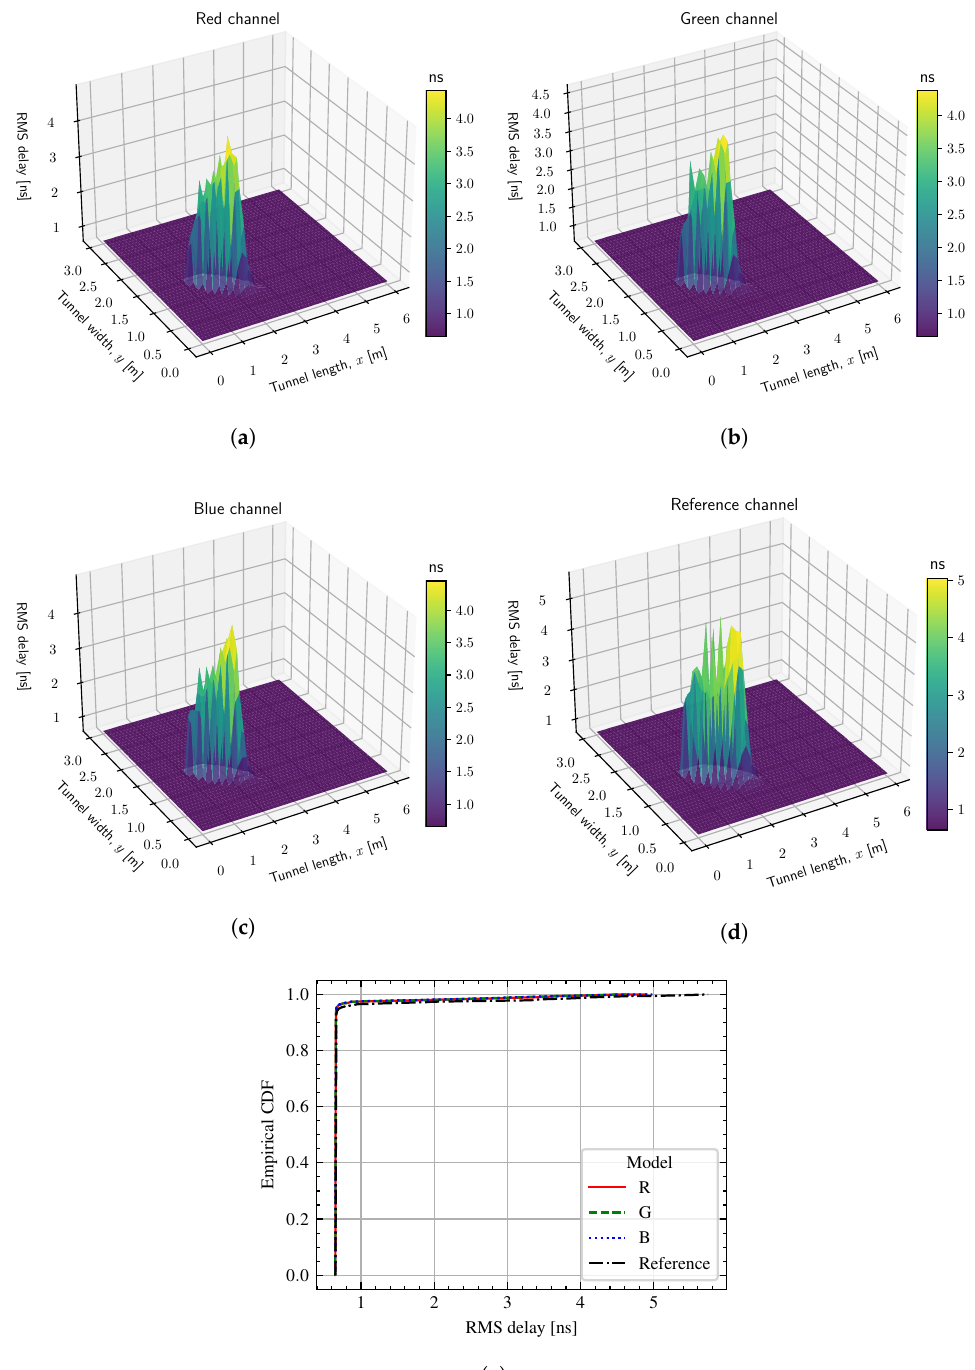
Figure 9. RMS delay: ( a ) Between red LED and red PD; ( b ) Between green LED and green PD; ( c ) Between blue LED and blue PD; ( d ) Reference model. ( e ) Empirical CDF for RMS delay for red, green, and blue channels in the proposed model and for RMS delay in the reference